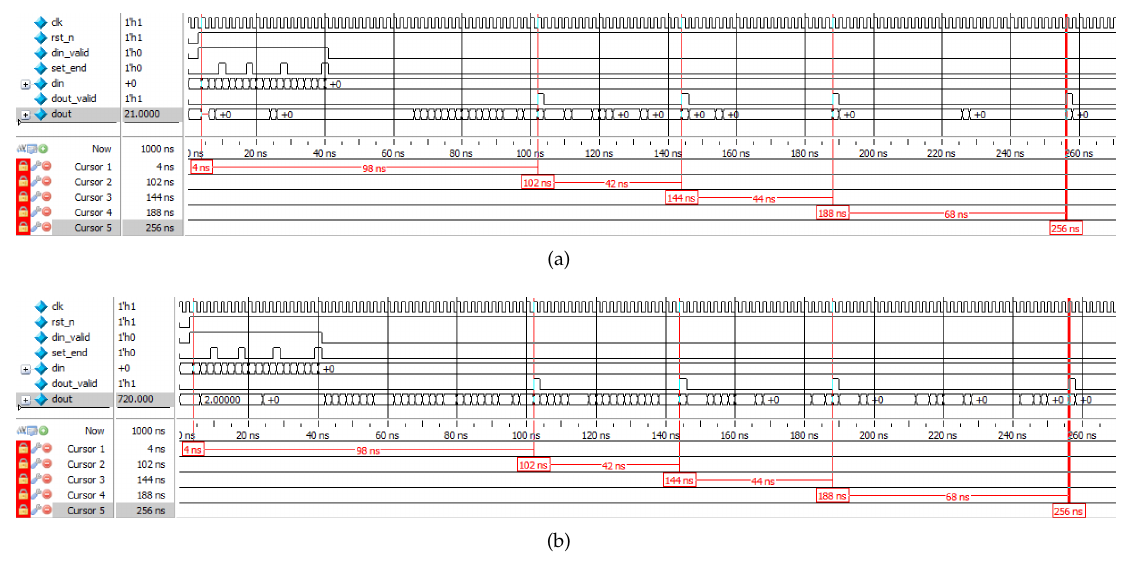
Figure 13. Pre-synthesis simulation. ( a ) reduction operator is a double-precision floating-point adder with a 14-stage pipeline; ( b ) reduction operator is a double-precision floating-point multiplier with a 14-stage pipeline.